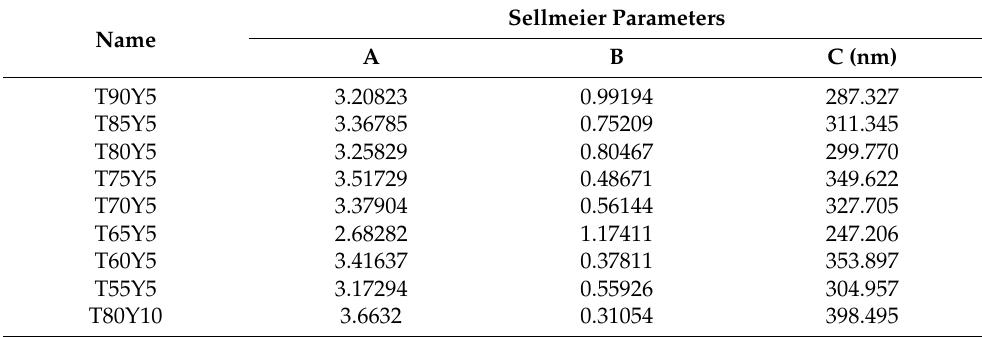
Table 3. Sellemeier parameters A, B and C obtained with a least-square fitting procedure for each of the TZY glass